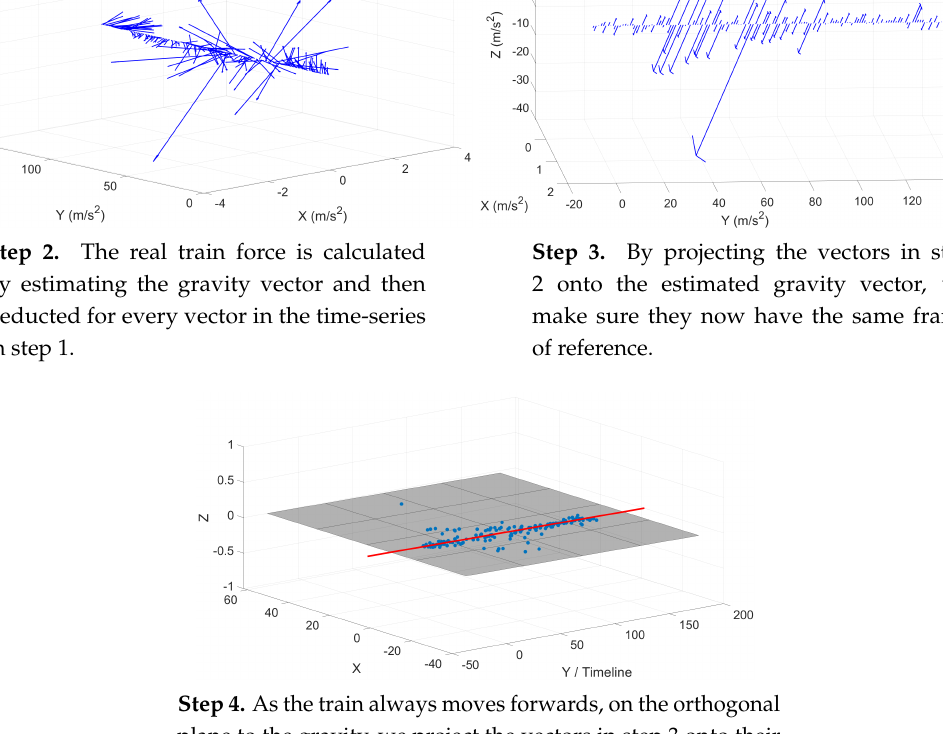
Figure 6. A visual demonstration of the step process to handle unconstrained phone placements and to obtain real train accelerations using PCA on a real-world time-series of 150 accelerometer